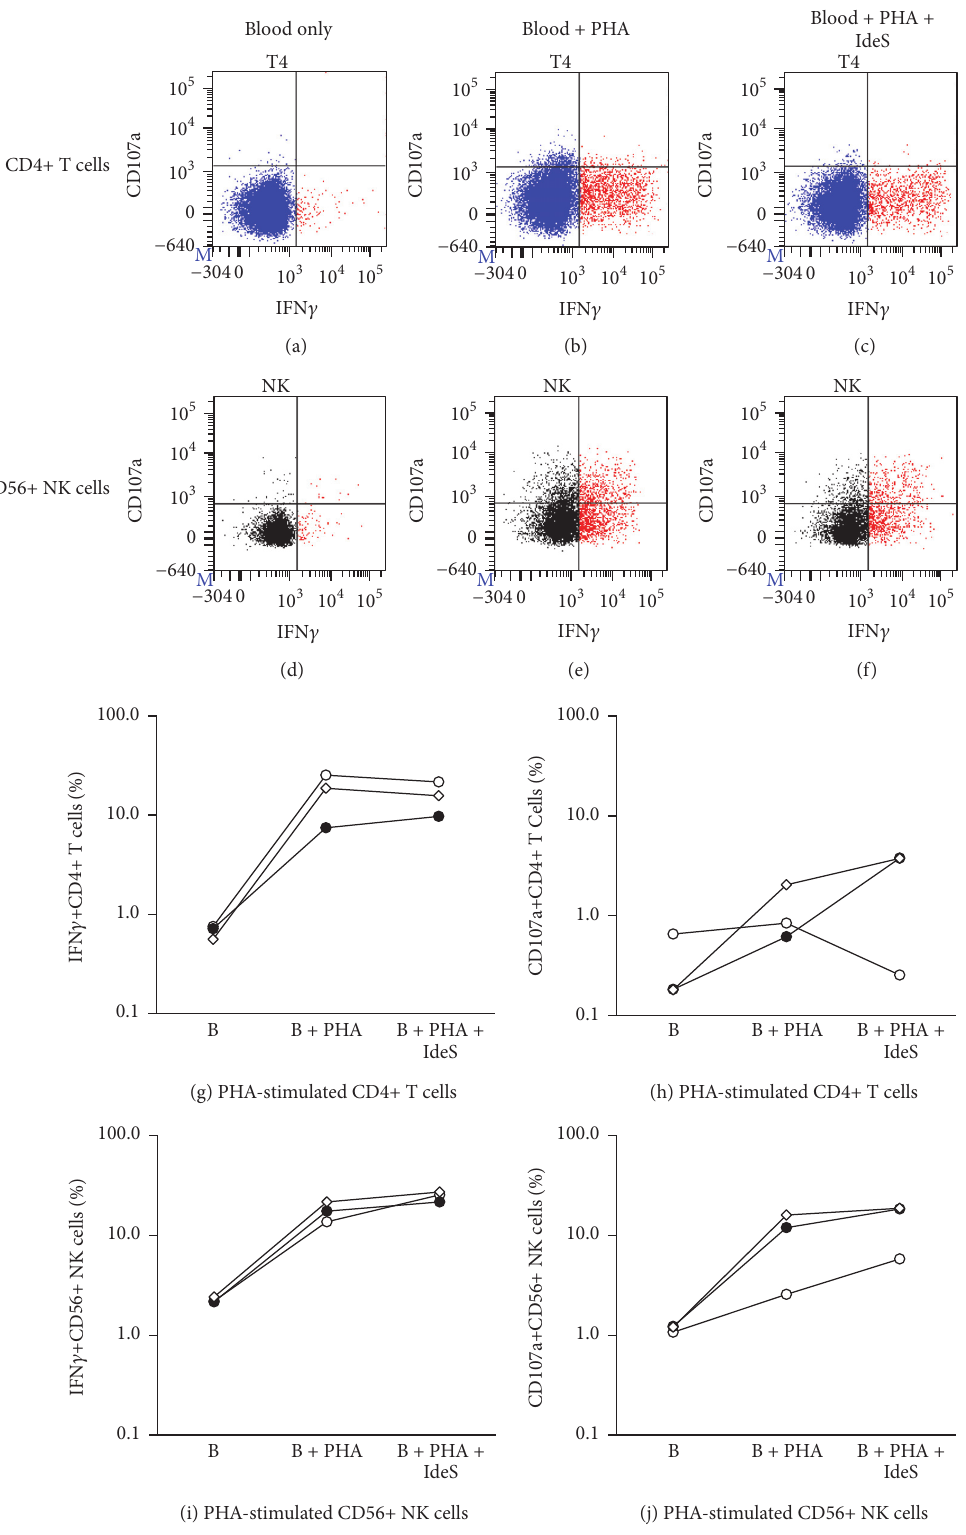
Figure 7: The effect of IdeS on CD4+ T cell and CD56+ NK cell activation in response to PHA. Upper (a–f): a typical result of CD4+ T cell and CD56+ NK cell response to PHA (positive control) with or without IdeS in the CMV-Th and CMV-NK assay. Lower (g–j): the summary of 3 sets of experiment results using 3 different normal individuals. Each line with each symbol describes the result from one normal individual. B: